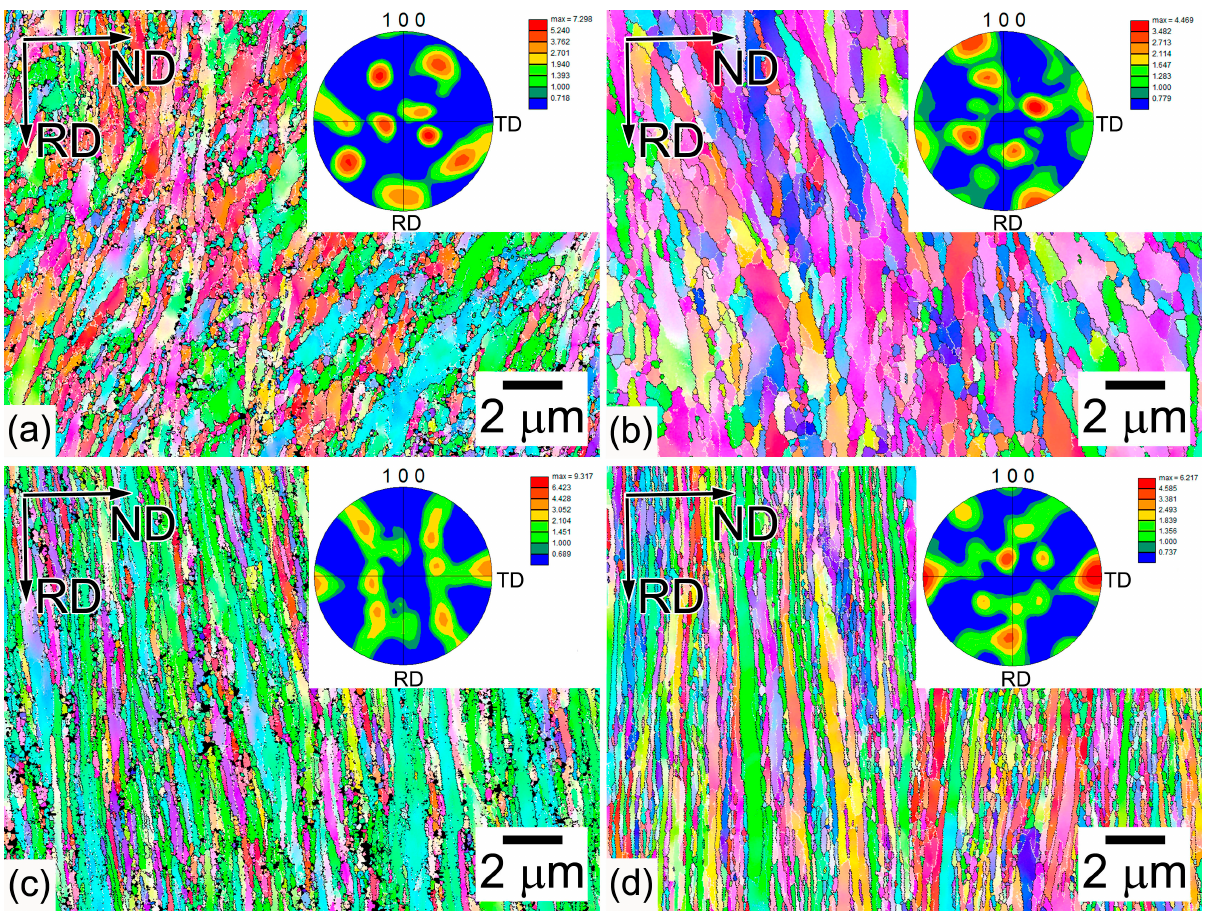
Figure 2. Microstructures in steel after tempforming at ( a , c ) 600 °C to a total strain of ( a ) 0.89 and ( c ) 1.4, and ( b , d ) 650 °C to a total strain of ( b ) 0.5 and ( d ) 1.4. The white and black lines mean boundaries with misorientations from 2 to 15 deg and above 15 deg,